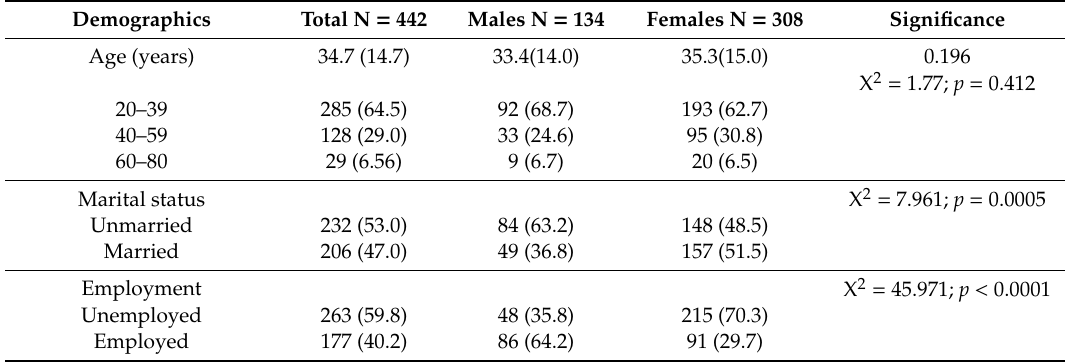
Table 1. Sociodemographic, anthropometric, and cardiometabolic characteristics of the study sample